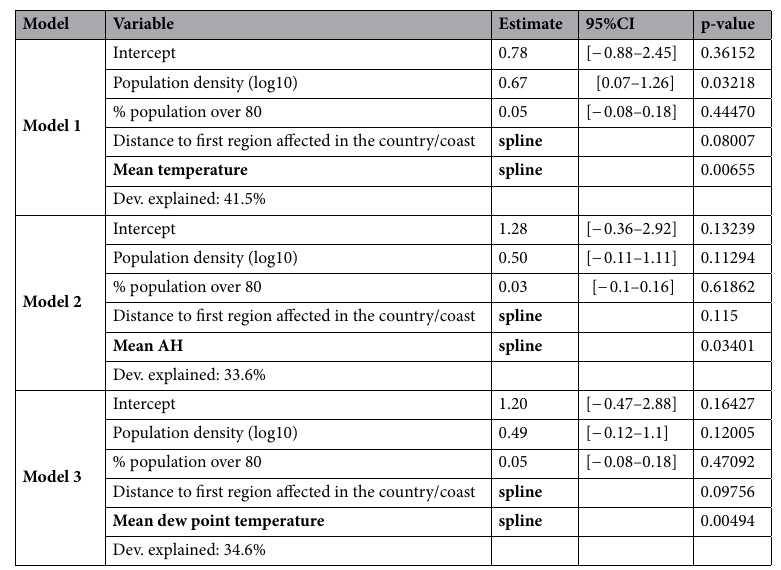
Table 1. Multivariable model results for the relationship between R 0 and weather parameters, obtained with the hierarchical generalized additive model. Weather parameters are temperature, AH, and DP temperature, adjusted for distance to the first region affected, population density, and elderly population. Non-linear effects are presented in Fig. 6. Models assuming linear effects for weather covariates are presented in Table S4.